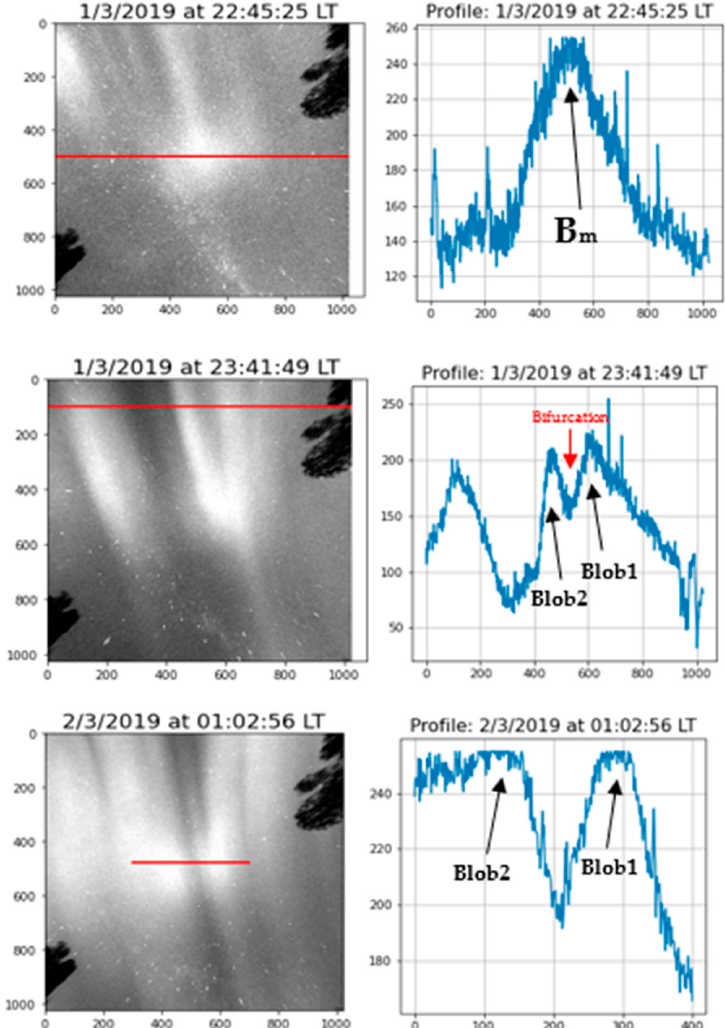
Figure 10. Signatures of EPB bifurcating blob. The images and the zonal relative intensity profile (red line) are shown. The first panel is the blob yet to experience bifurcation. The second panel is the blob bifurcating. The third panel is the presence of two blobs already split in two. EPB means Equatorial Plasma Bubbles.